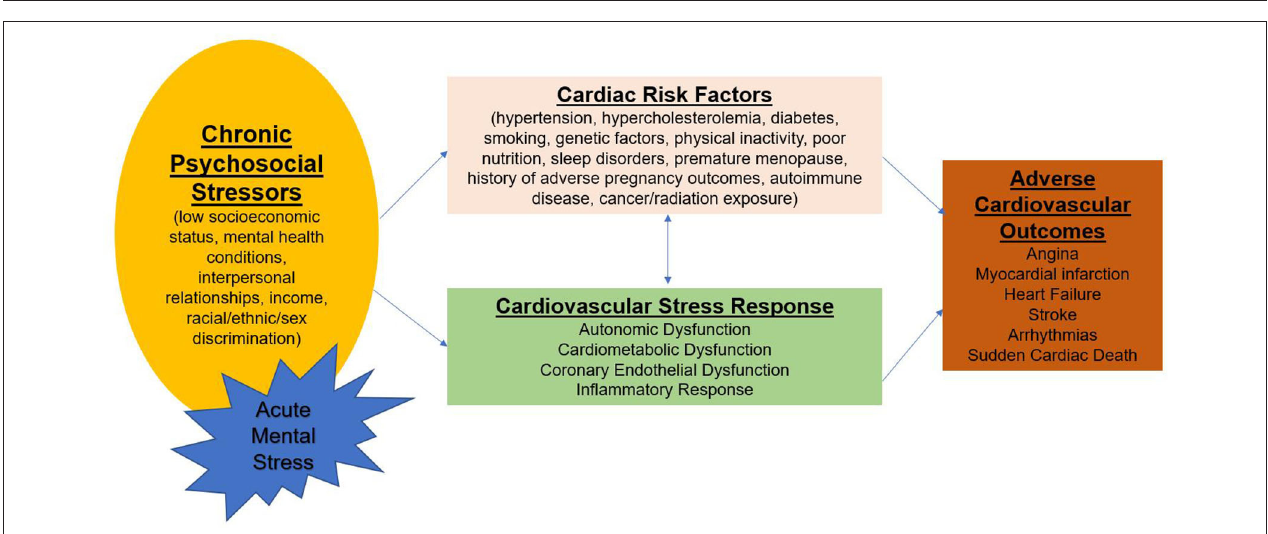
FIGURE 2 | Psychological stress, risk factors, and cardiovascular disease. Acute episodes of mental stress superimposed on chronic stress influence the cardiovascular stress response involving autonomic dysfunction, cardiometabolic dysfunction, endothelial dysfunction, and inflammatory pathways. These pathways are modulated by cardiac risk factors leading to adverse cardiovascular